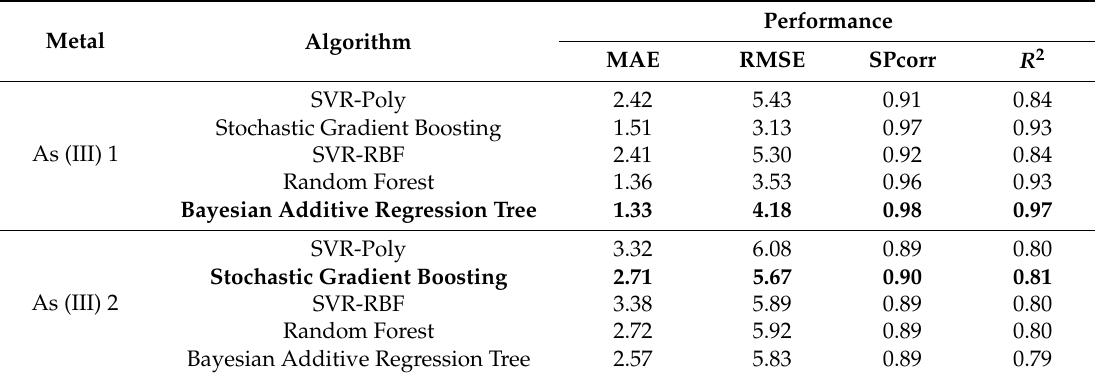
Table 5. The performances of five (5) machine learning algorithms (MLA) models on independent test data (20%) of As (III)